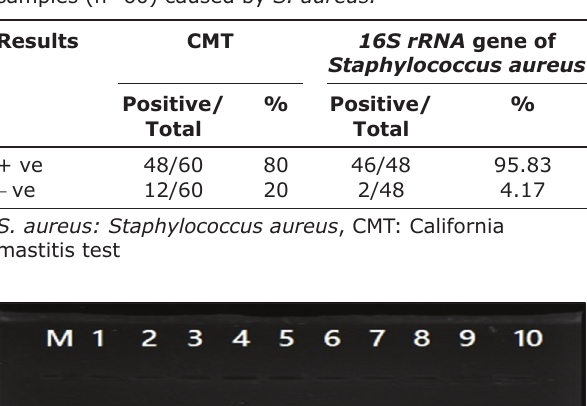
Table-2: Prevalence of subclinical mastitis in cow’s milk samples (n=60) caused by S. aureus.